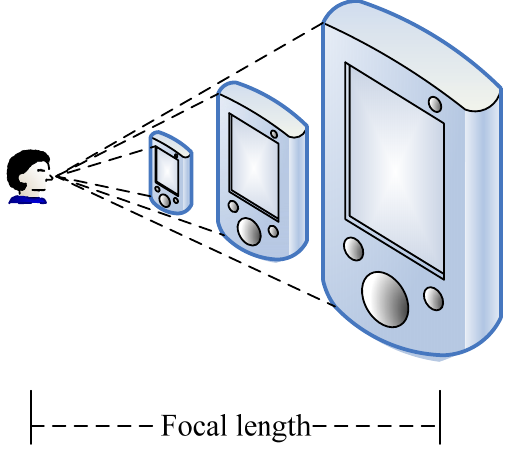
Figure 8. Focal length plan.